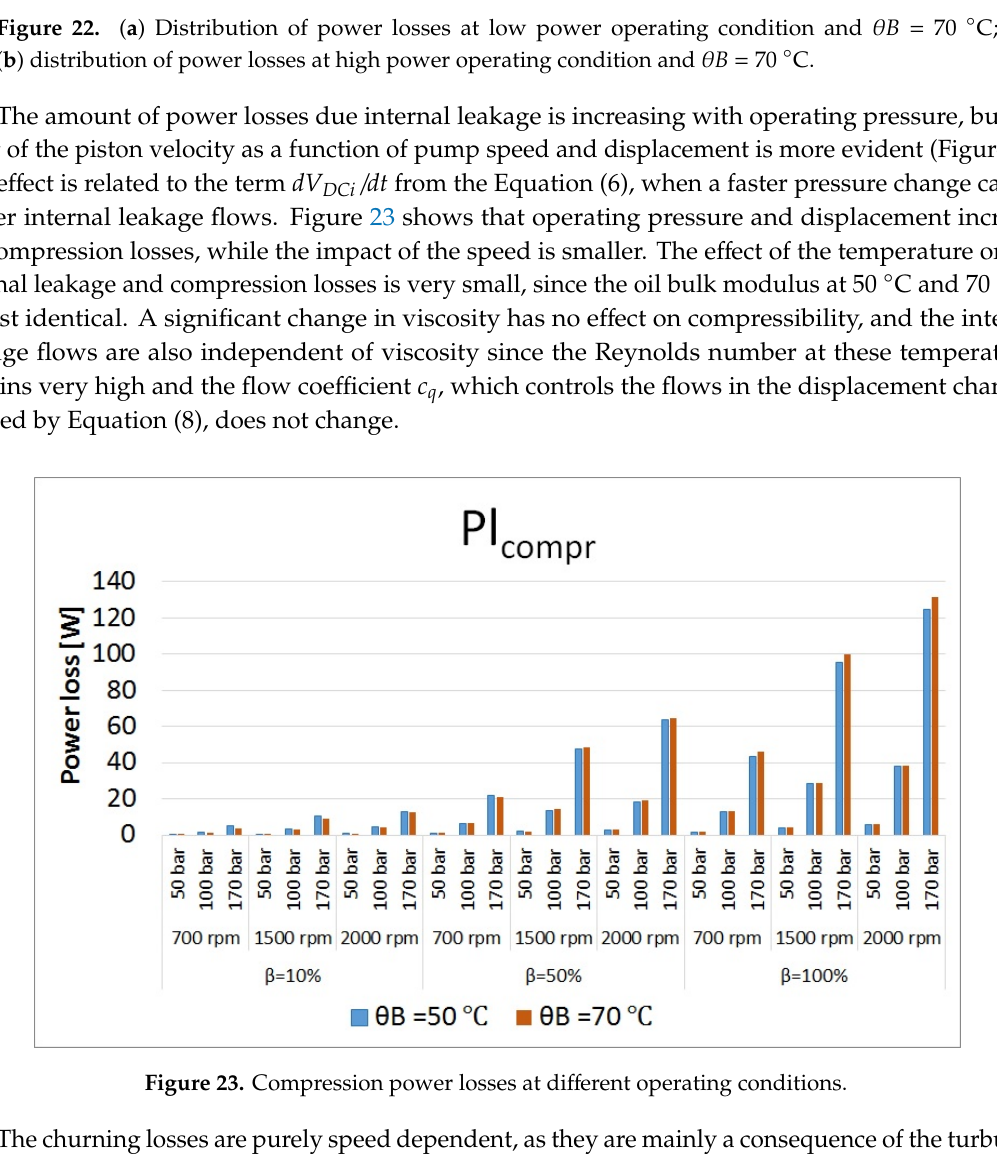
Figure 24. Total power losses in piston/cylinder bore interfaces at different operating conditions.